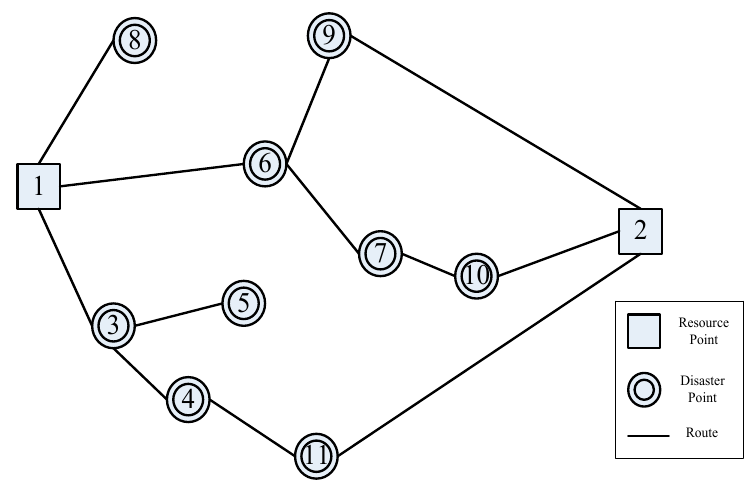
Figure 8. Schematic diagram after new resource point is added (Case 2). Table 12. New resource transit routes and new travel times after new resource point is added (Case 2). Resource Transit Route